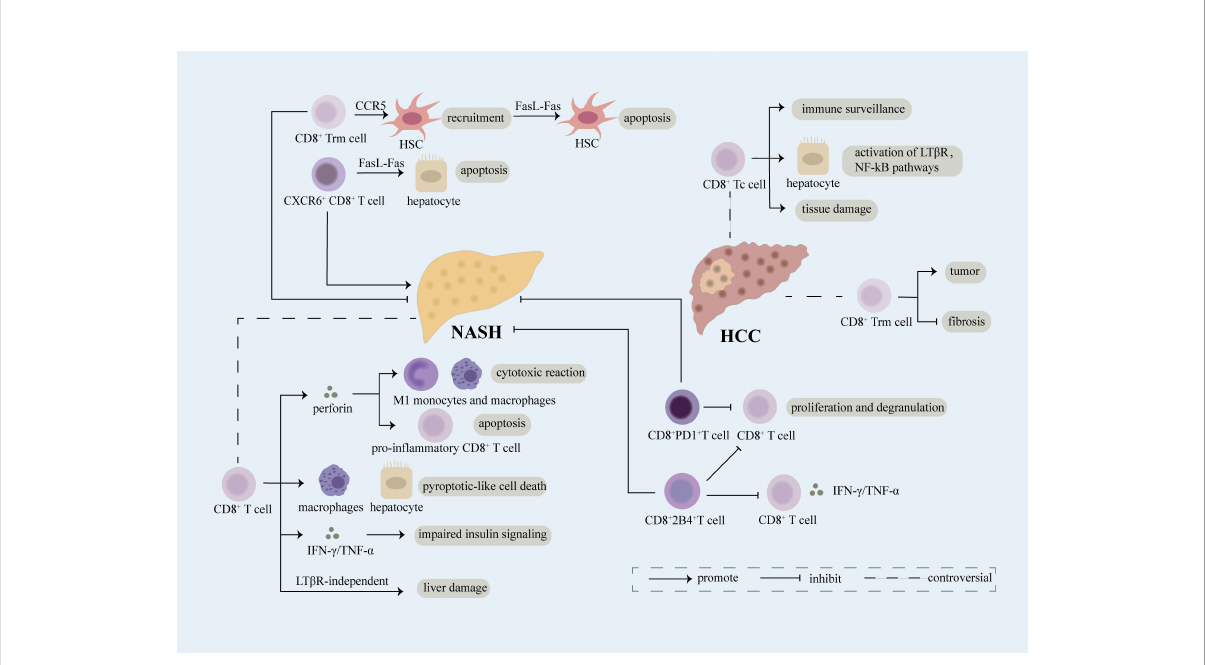
FIGURE 2 Role of CD8 + T cell. CD8 + T cells expressing various receptors on the cell surface play a complex role in the evolvement of NASH and NASH- induced HCC. Breaking down of the balance between damage and repairment functions of CD8 + T cells may result in the exacerbation of diseases. CD8 + Trm cells induce the recruitment of HSC in a CCR5-dependent manner and further lead to apoptosis of HSC through FasL-Fas thus inhibiting fi brosis in NASH. CD8 + T cells play an anti-in fl ammatory part in NASH through secretion of perforin which can not only induce cytotoxic reaction in M1 monocytes and macrophages but also promote apoptosis of CD8 + T cells producing pro-in fl ammatory cytokines. Upregulation of PD1 on CD8 + T cells restricts proliferation and degranulation of CD8 + T cells, meanwhile, increased 2B4 on CD8 + T cells leads to reduced proliferation rate and decreased secretion of in fl ammatory cytokines, thus relieving liver damage. However, CD8 + T cells have been reported as a promoter of NASH. Mechanically, CD8 + T cells can induce pyroptotic-like cell death in macrophages and hepatocytes, result in impaired insulin signaling through release of IFN- g /TNF- a , and lead to liver damage in a LT b R-independent manner. Moreover, CXCR6 + CD8 + T cells accelerate apoptosis of hepatocytes dependent of FasL-Fas which facilitate NASH. CD8 + Tc cells, mainly effector cells of CD8 + T cells, can not only function as immune surveillance cells to suppress NASH-induce HCC but also act as pro-tumor cells through interacting with NKT cells to activate LT b R, NF-kB pathways and inducing exacerbation of tissue damage. CD8 + Trm cells, a kind of CD8 + memory cells, have been veri fi ed as pro-tumor cells in NASH-induced HCC. However, evidence has shown that CD8 + Trm cells can restrict the evolution of fi brosis in NASH which probably limits the transition of NASH into